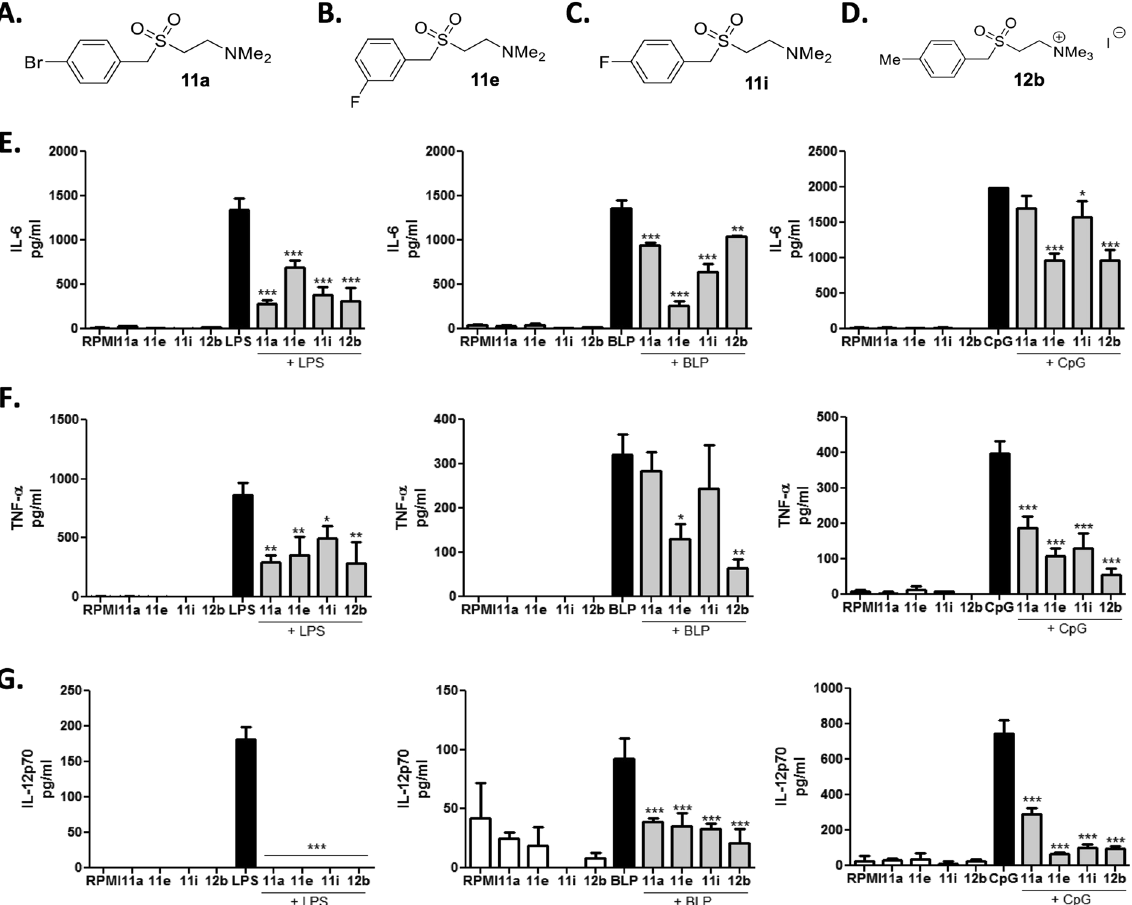
Figure 1. Small molecule analogues (SMAs) of the parasitic worm product ES-62 inhibit PAMP-induced cytokine production. The structures of SMAs 11a ( A ), 11e ( B ), 11i ( C ) and 12b ( D ) are shown. BmDCs were incubated with SMA (5 μ g/ml) for 18 hours before stimulation with LPS, BLP (both 100 ng/ml) or CpG (0.1 μ M) and the production of IL-6 ( E ) TNF- α ( F ) and IL-12p70 ( G ) was measured by ELISA. Data are expressed as means (of triplicate determinations) ± SD and analysed using one-way ANOVA with Bonferroni post-test where * p < 0.05; ** p < 0.01; *** p < 0.001 compared to relevant PAMP. All data are representative of at least two independent